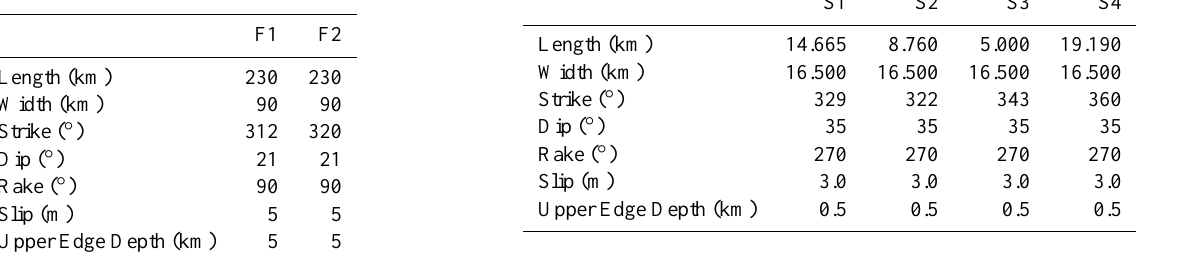
Table 2. Seismic parameters for the tsunamigenic earthquake sources used to characterise the 365 AD scenarios. Subfaults F1 and F2 correspond to the fault hypotheses 365 F1 (the southern seg- ment) and 365 F2 (the northern segment) in Fig. 2. The 365 F3 scenario corresponds to the sum of both segments.